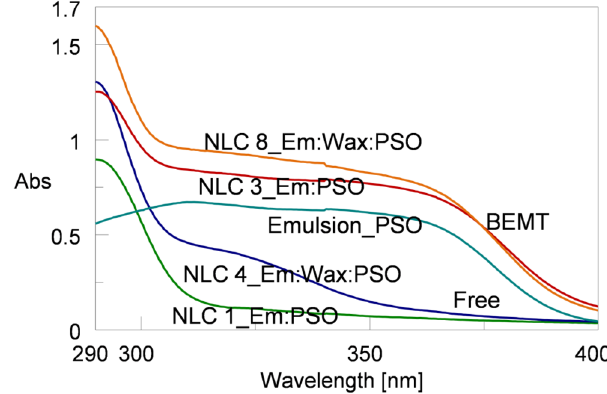
Figure 8. UV absorbance of free and BEMT – NLCs in dispersion in comparison with reference